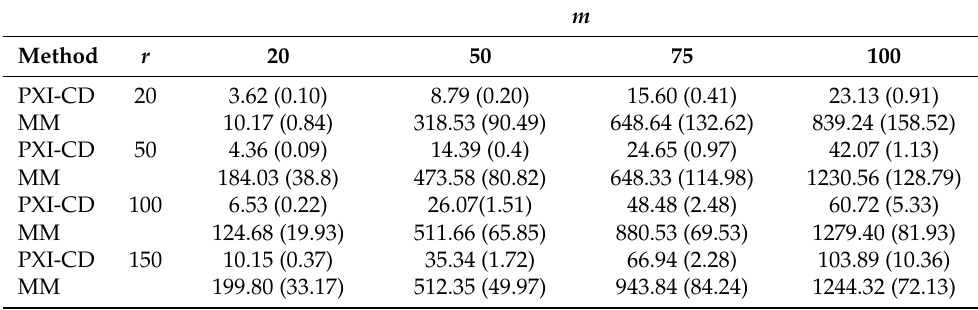
Table 3. The running times (s) when V i are low-rank, n = 1000, and γ 0 = 10.